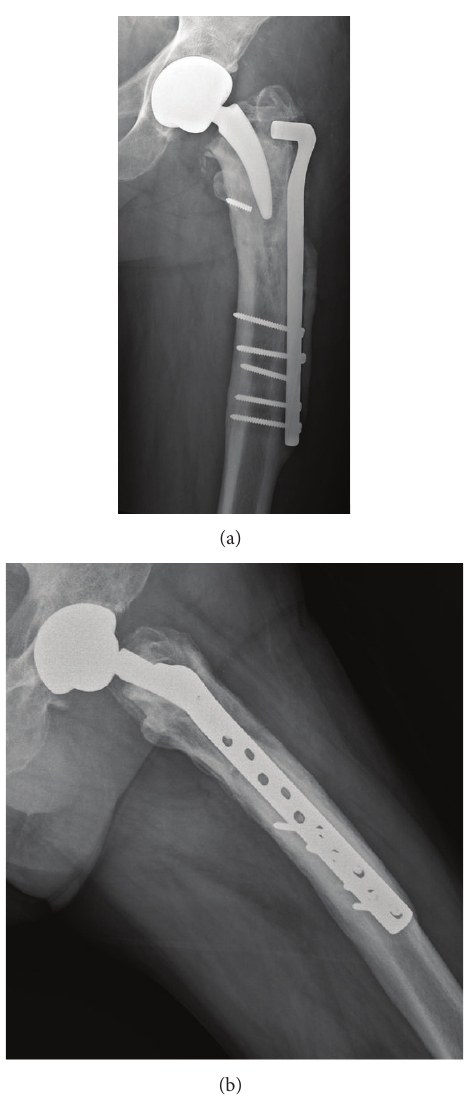
Figure 2: Anteroposterior (a) and lateral (b) radiographs of the left hip one year after the conversion to a short-stemmed